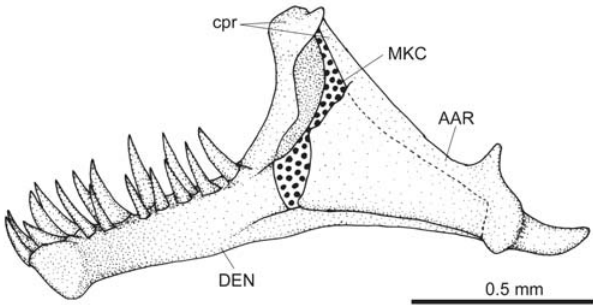
Fig. 3. Mandible of Ituglanis macunaima , paratype, MZUSP 86251 (25.5 mm SL), medial view of right side. Abbreviations: AAR, anguloarticular; cpr, coronoid process; DEN, dentary; MKC, Meckel’s cartilage.